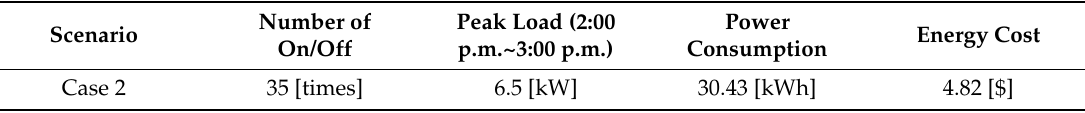
Table 5. Summary of Case 2 simulation